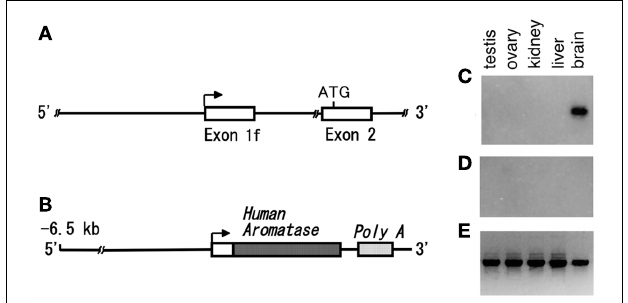
FIGURE 1 | Construction of the brain-specific aromatase transgene. (A) The amino acid sequence of mouse aromatase is coded from the ATG translational start site in the exon 2 to termination codon in exon 10 of the gene.The exon 1f, flanked with brain-specific regulatory elements in the promoter region, is brain-specifically selected among multiple exons 1 of the gene. (B) The brain-specific aromatase transgene was constructed by linking human aromatase cDNA with the − 6.5-kb promoter region of the brain-specific exon 1f. (C–E) Tissue total RNAs were prepared from testes, ovaries, kidneys, livers, and brains of ArTG mice (8–10 weeks of age) carrying the brain-specific aromatase transgene and subjected to RT–PCR specific for human aromatase in the presence (C) or absence (D) of reverse transcriptase. As controls, RT–PCRs specific for β -actin (E) were also